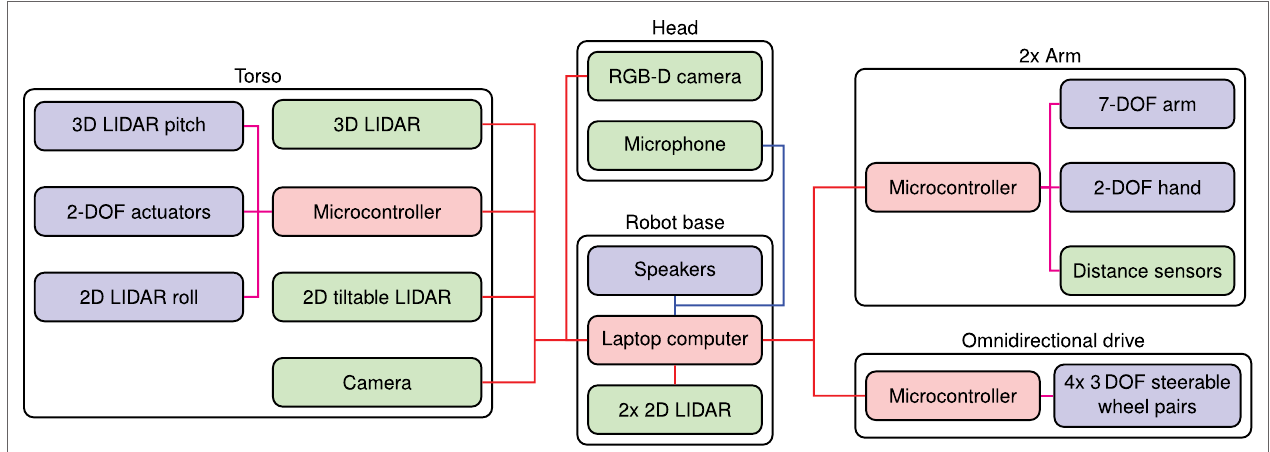
FIgURe 2 | overview of the mechatronic design of cosero . Sensors are colored green, actuators blue, and other components red. USB connections are shown in red, analog audio links are shown in blue, and the low-level servo connections are shown in